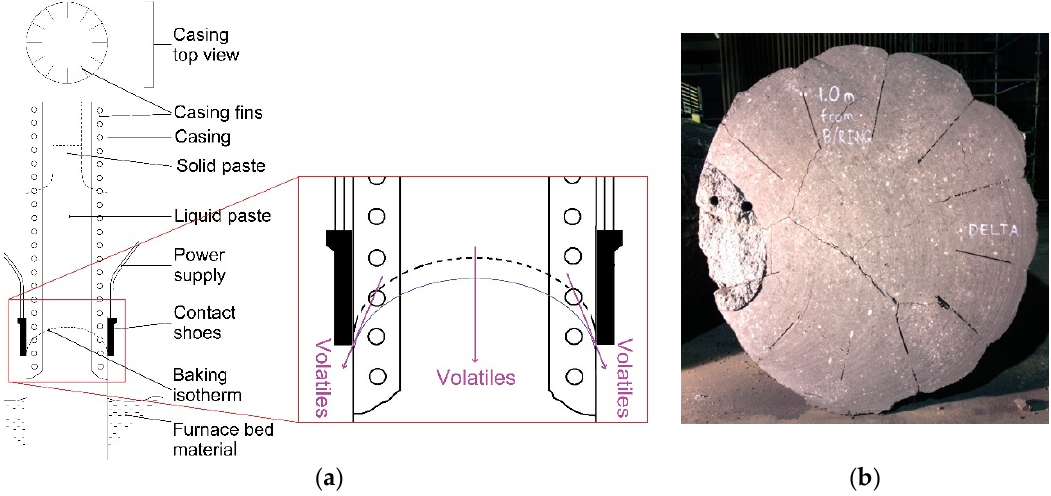
Figure 9. ( a ) Representation of a partial Søderberg electrode column, adapted from Beukes et al. [4], with the contact shoes area enlarged (indicated by the square red block); ( b ) cross section of another electrode from the same SAF that was cut off with a diamond wire saw approximately 1.0 m below the contact shoes.